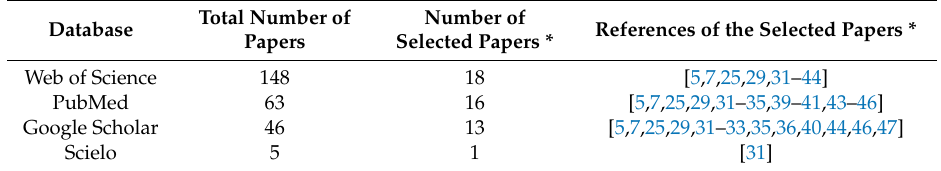
Table2. Numberofpublicationsretrievedfromdatabasesearchesusingtheterm“Candidahaemulonii”.